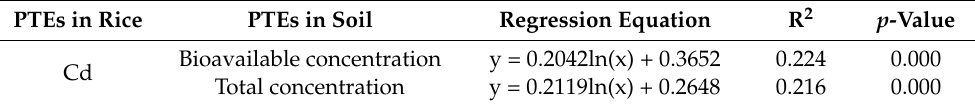
Table 5. Relationships between PTEs in rice grain and total and bioavailable PTEs in soil. PTEs in Rice PTEs in